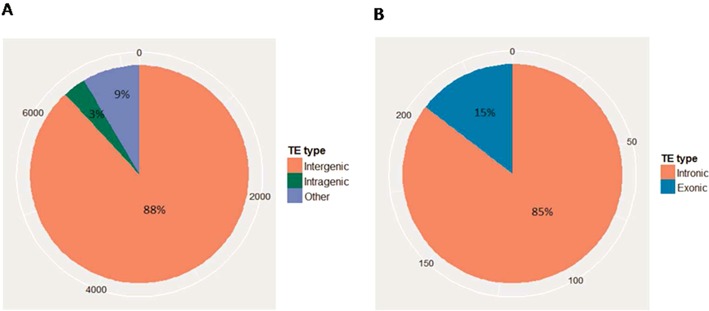
Abundance and classification of all TEs (A), and intragenic TEs (B) in the A. thaliana genome. The outermost circle indicates the numbers of TEs.